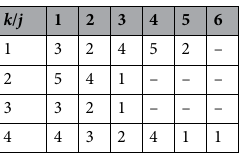
Table 1. Pe k j values for each Qa k and each V k j